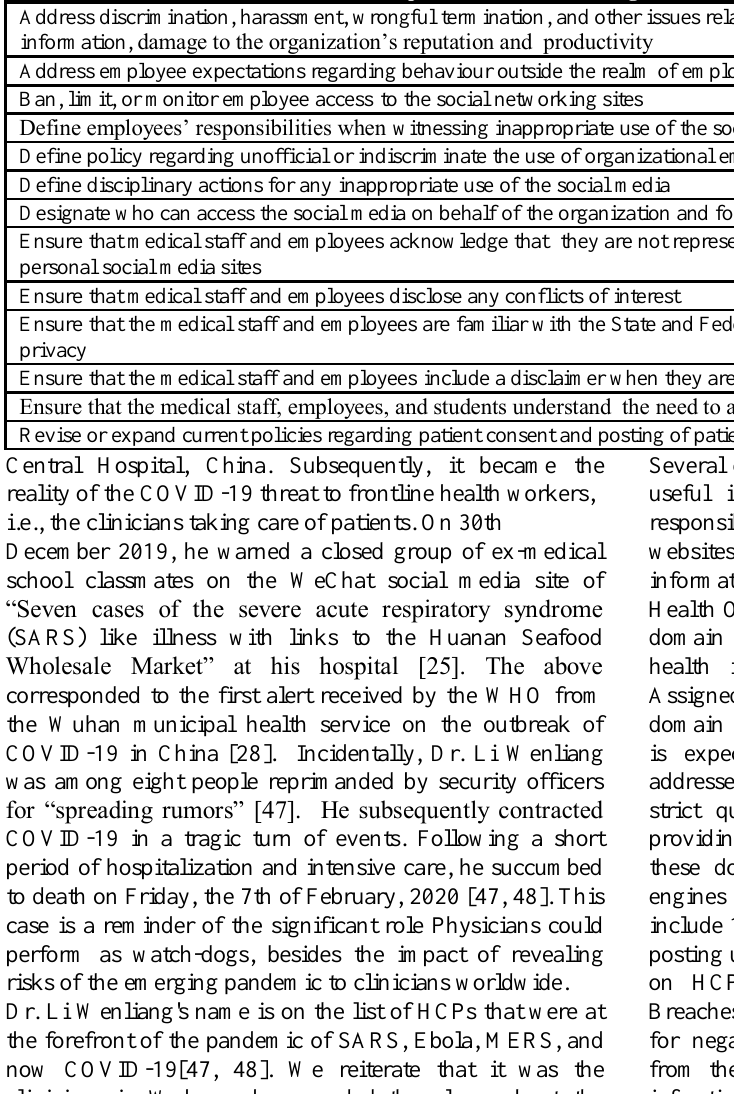
Table 3. Concepts for Health Care Organizations’ social media policies